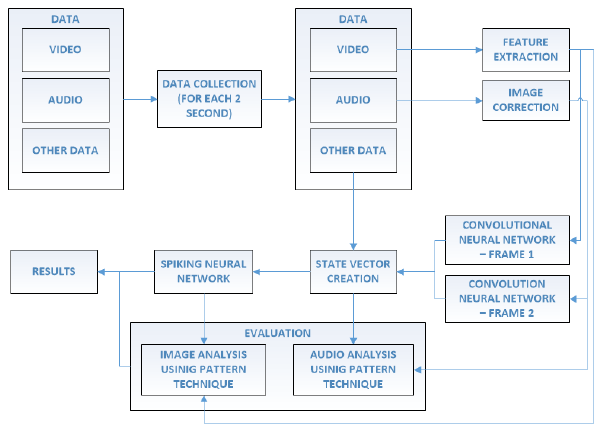
Figure 3. Visualization of the proposed architecture for data analysis in order to inform system users about possible